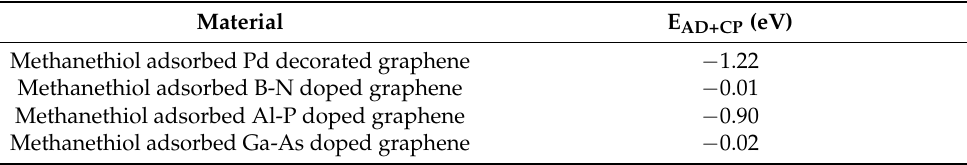
Table 2. The total energies, adsorption energies between biomarker and graphene.